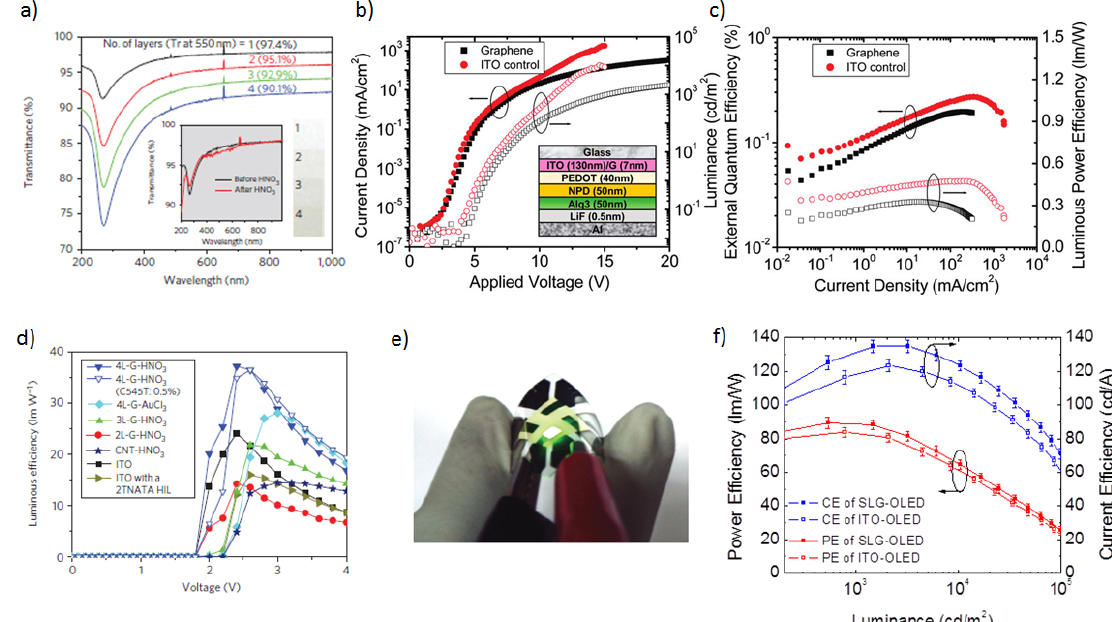
Figure 5. ( a ) Transmittance of the roll-to-roll layer-by-layer transferred graphene films on quartz substrates. The inset shows the transmittance spectra of graphene films with and doping and the optical images for the corresponding number of transferred without HNO 3 layers (1 × 1 cm 2 ) [49]; ( b ) Current density (filled symbols) and luminance (open symbols) vs. applied forward bias for an OLED on graphene (squares) and ITO (circles), with an OLED device structure of anode/PEDOT:PSS/NPD/Alq3/LiF/Al; ( c ) External quantum efficiency (EQE) (filled symbols) and luminous power efficiency (open symbols) for an OLED on graphene film (squares) and ITO glass (circles) [12]; ( d ) Power efficiencies of or AuCl ) and ITO as the OLED devices using various graphene layers (doped with HNO 3 3 anode; ( e ) Photograph of a flexible fluorescent green OLED with a four-layered graphene anode (4L-G) doped with HNO3 (4L-G-HNO3) [51]; ( f ) Power efficiency and current efficiency of white OLED (WOLED) based on ITO and single layer graphene electrode